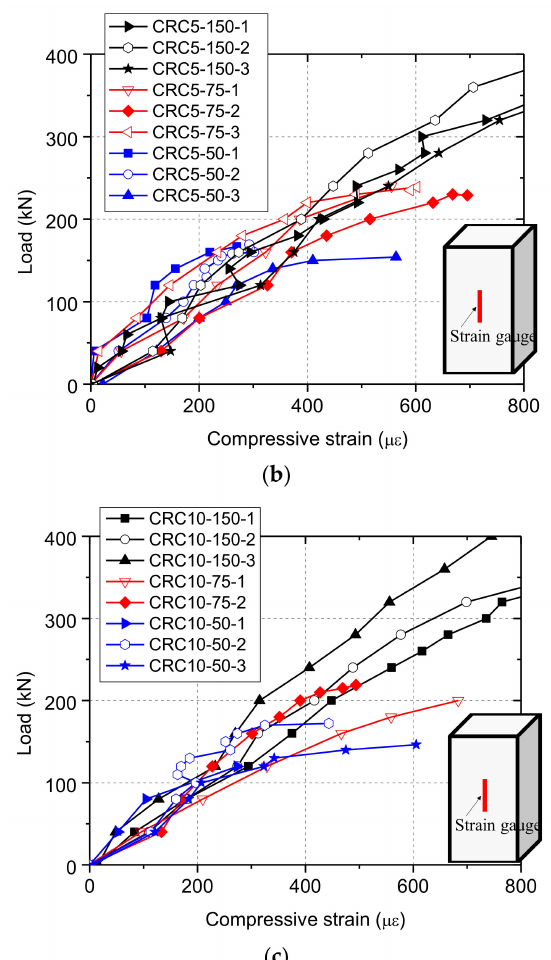
Figure 11. The load–strain curves of specimens under partial contact loading: ( a ) NC; ( b ) CRC5; ( c )